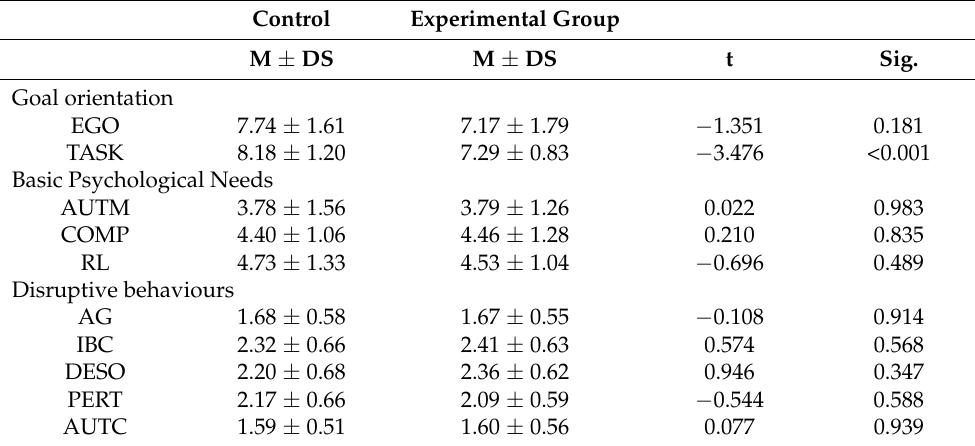
Table 2. Initial results of the independent samples Student’s t-test. Control